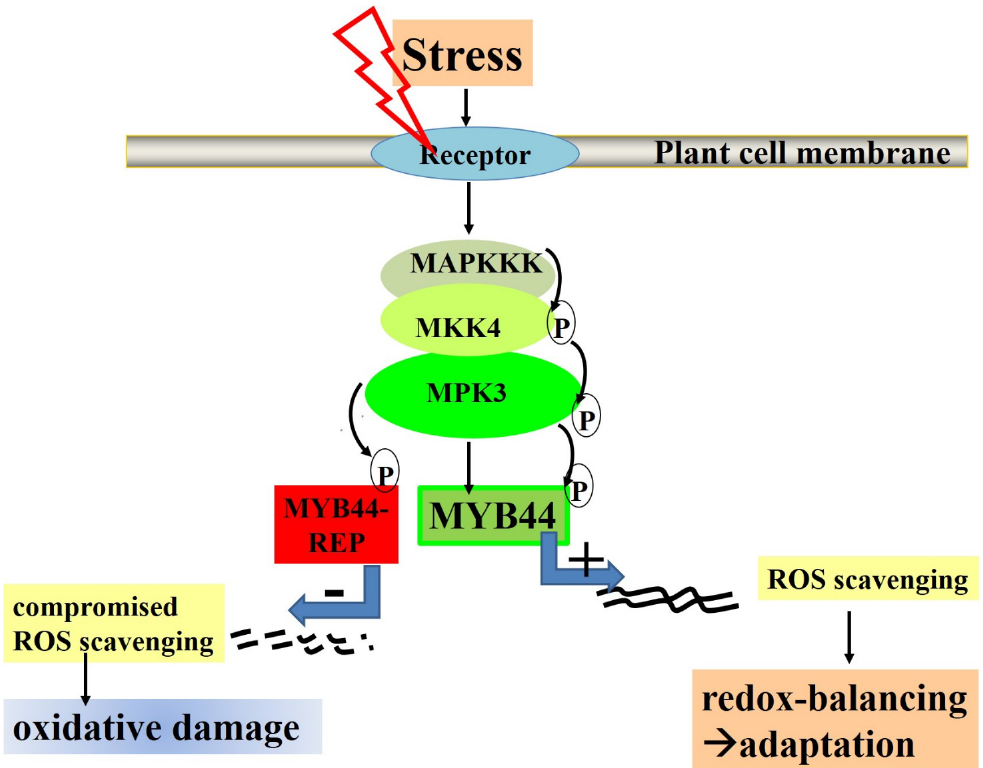
Figure 7. Proposed model of MYB44 function in stressed plants. Upon stress perception, a mitogen-activated protein kinase cascade is activated. MAPKK4 phosphorylates and thereby activates MPK3. MPK3 phosphorylates MYB44, thereby stimulating MYB44 function as transcriptional inducer [40]. Right : MYB44-induced target genes, directly or indirectly, enhance the antioxidant capacity, e.g., through activating reactive oxygen species (ROS)-scavenging enzymes. This ultimately leads to a balanced redox state and prevention of cell death; and Left : in contrast, dominant repression of MYB44 target genes adversely affects redox-balancing, leading to massive accumulation of destructive